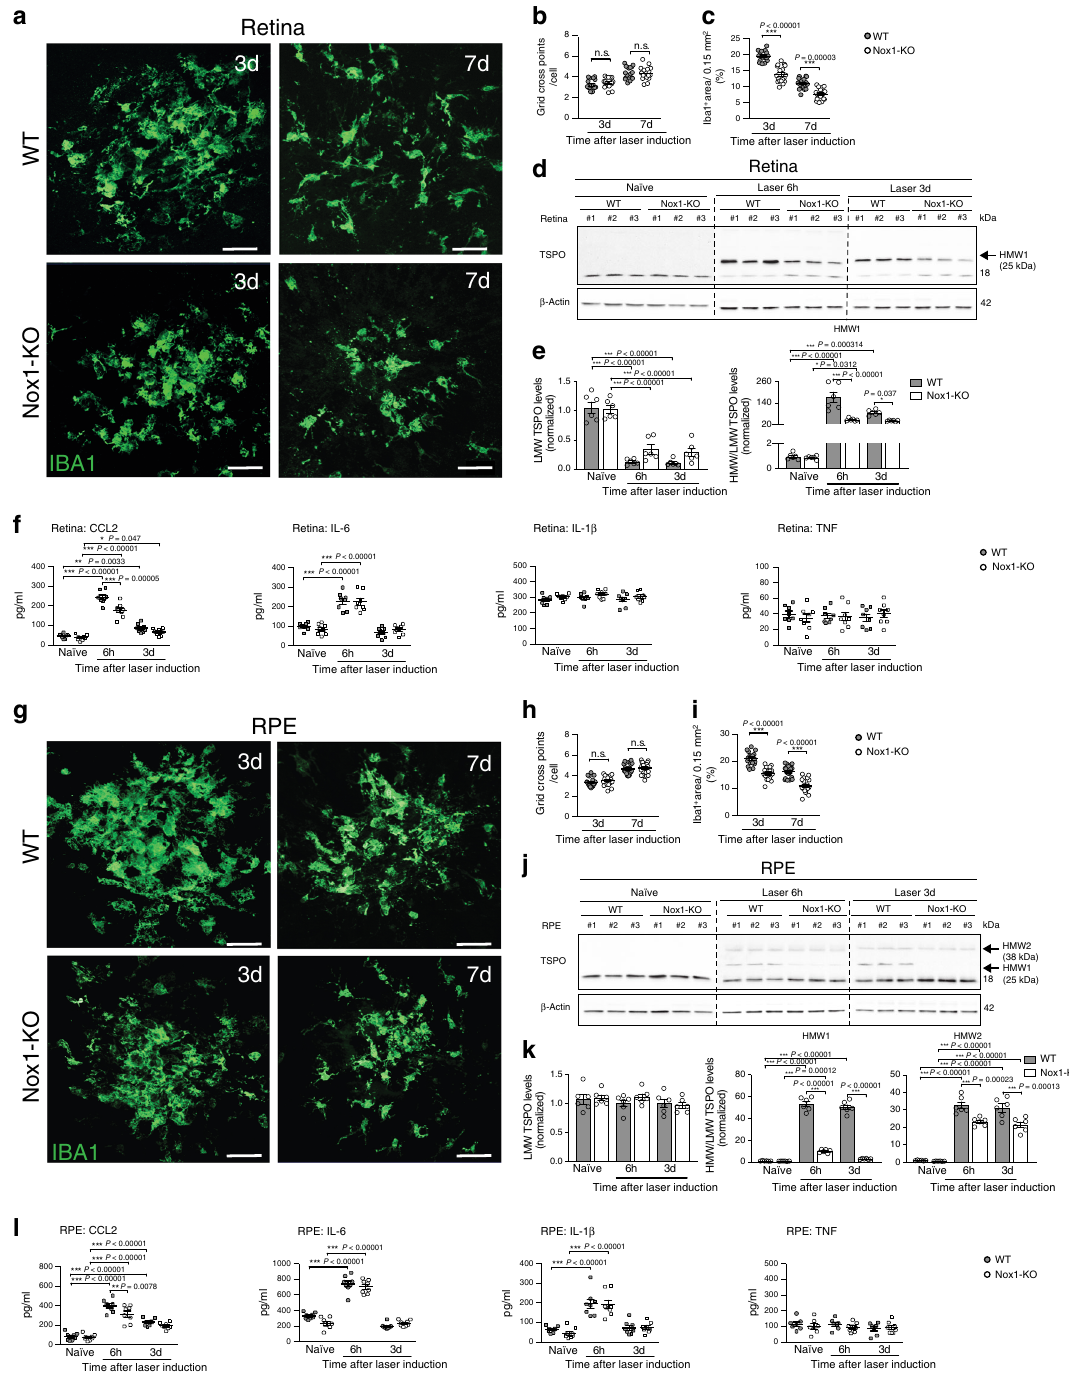
Fig. 7 NOX1 de fi ciency reduces mononuclear phagocyte reactivity in laser-induced CNV in mice. a Representative images show accumulation of Iba1 + cells within the laser lesion in retinal fl at mounts. Scale bar: 50 μ m. b Quanti fi cation of Iba1 + cell morphology within laser lesions. 3 d n = 18; 7 d n = 22 spots. c Quanti fi cation of Iba1 + area of the laser lesions. 3 d n = 18; 7 d n = 22 spots. d TSPO protein levels in retinal cell extracts of naïve and lasered WT and Nox1-KO mice at indicated time points. Each lane represents an individual retina. Dotted line indicates individual blots, which were processed in parallel. e Densitometric analysis of western blots. LMW TSPO signals were normalized to β -Actin and HMW:LMW TSPO ratio determined. n = 6 retinas from two independent experiments. f Cytokine levels in retinas of naïve and lasered WT and Nox1-KO mice at indicated time points. n = 8 retinas from individual mice. g Representative images of Iba1 + cells within the laser lesion in RPE/choroidal fl at mounts. Scale bar: 50 μ m. h Quanti fi cation of Iba1 + cell morphology within laser lesions. 3 d n = 18, 7 d n = 22 spots. i Quanti fi cation of Iba1 + area of the laser lesions. 3 d n = 18, 7 d n = 22 spots. j Western blots showing TSPO expression in RPE/choroidal cell extracts of naïve and lasered WT and Nox1-KO mice at indicated time points. k Densitometric analysis of western blots. n = 6 RPE/choroids from two independent experiments. LMW lower molecular weight; HMW higher molecular weight. l Pro-in fl ammatory cytokine levels in RPE/choroids of naïve and lasered WT and Nox1-KO mice. n = 8 RPE/choroids from individual mice. Data show mean ± SEM. A linear mixed model was used for statistical analyses, * P < 0.05; ** P < 0.01; and *** P ≤ 0.001. Source data are provided as a Source Data fi